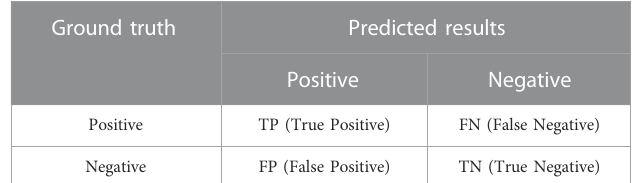
TABLE 1 Statistics of the datasets. TABLE 2 Confusion